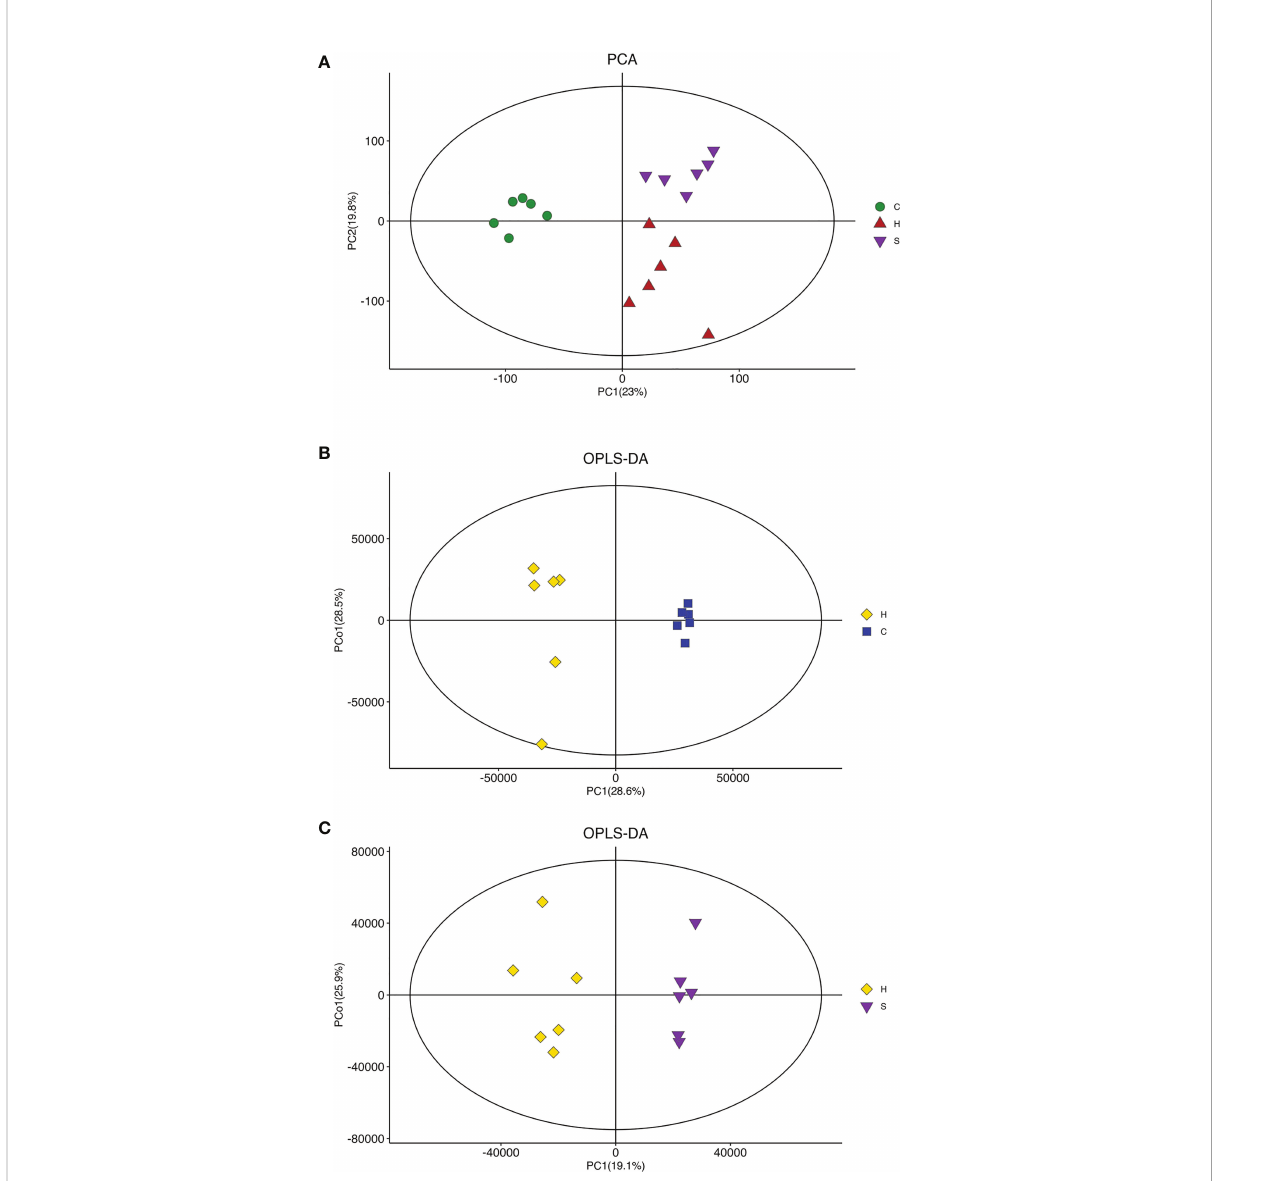
FIGURE 5 Effects of semaglutide on liver metabolomics in HFD-induced NAFLD model. (A) PCA was utilized to analyze the metabolites from NFD and HFD-fed rats with and without semaglutide treatment for 24 weeks; (B, C) OPLS-DA was utilized to analyze the metabolites between NCD and HFD group or HFD and HFD+sema group; PLS-DA, partial least squares discriminant analysis; OPLS-DA, orthogonal partial least squares discriminant analysis; NAFLD, non-alcoholic fatty liver